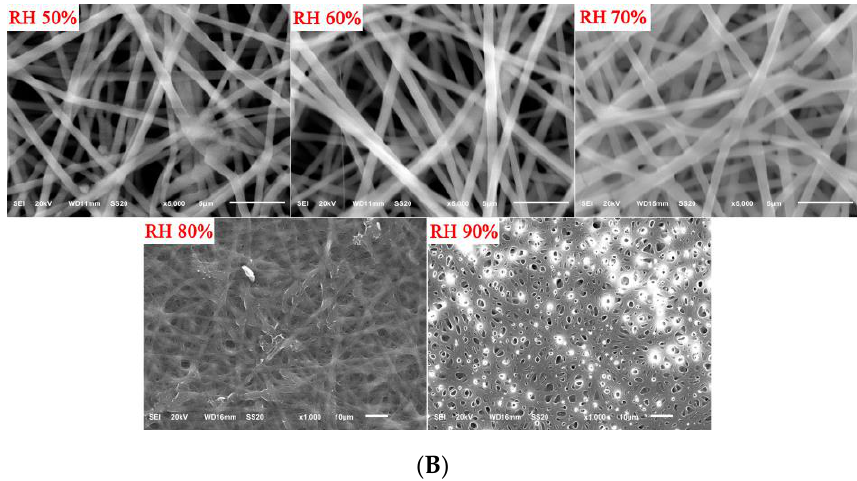
Figure 2. ( A ) SEM images and fiber diameter distributions of the gelatin/zein/glucose nanofibers fabricated by traditional electrospinning and air-assisted electrospinning (values with different superscript letters are significantly different, p < 0.05). ( B ) SEM images of gelatin/zein/glucose nanofibers prepared at 60 ◦ C and 50–90% RH for 24 h.